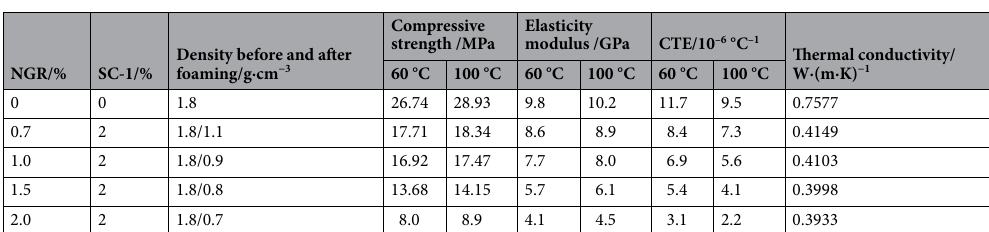
Table 1. Effect of foam additive on strength and thermal conductivity of hardened cement. The percentage of foaming agent and foam stabilizer is the mass percentage of Class G cement ash.